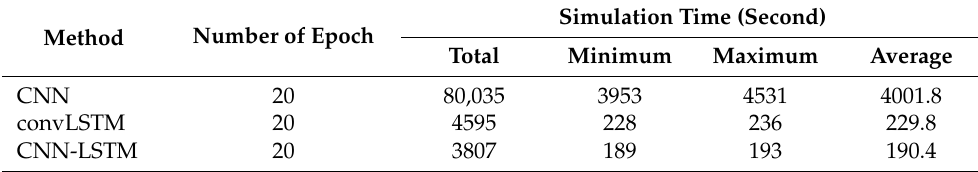
Table 11. Computational time for comparing deep learning